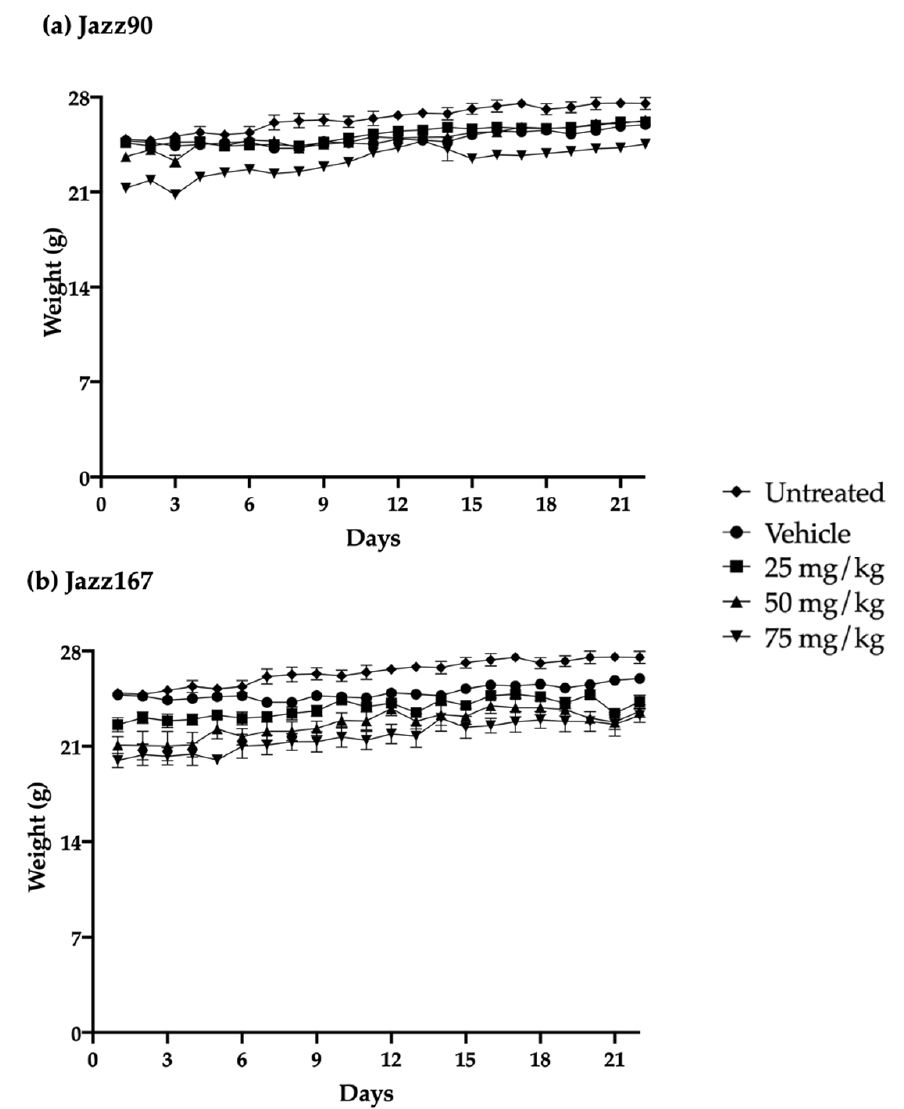
Figure 7. Daily BALB/c mouse body weight throughout Jazz90 and Jazz167 treatment. ( a ) Jazz90 and ( b ) Jazz167 were administered orally for 21 days at 25, 50 and 75 mg/kg. Vehicle control mice were treated with 0.5% DMSO (5 mL/kg). Points represent the mean ± S.E.M from 4-5 mice per group. Data were analysed using a two-way ANOVA coupled with a Bonferroni’s post-hoc test. None were significantly different.